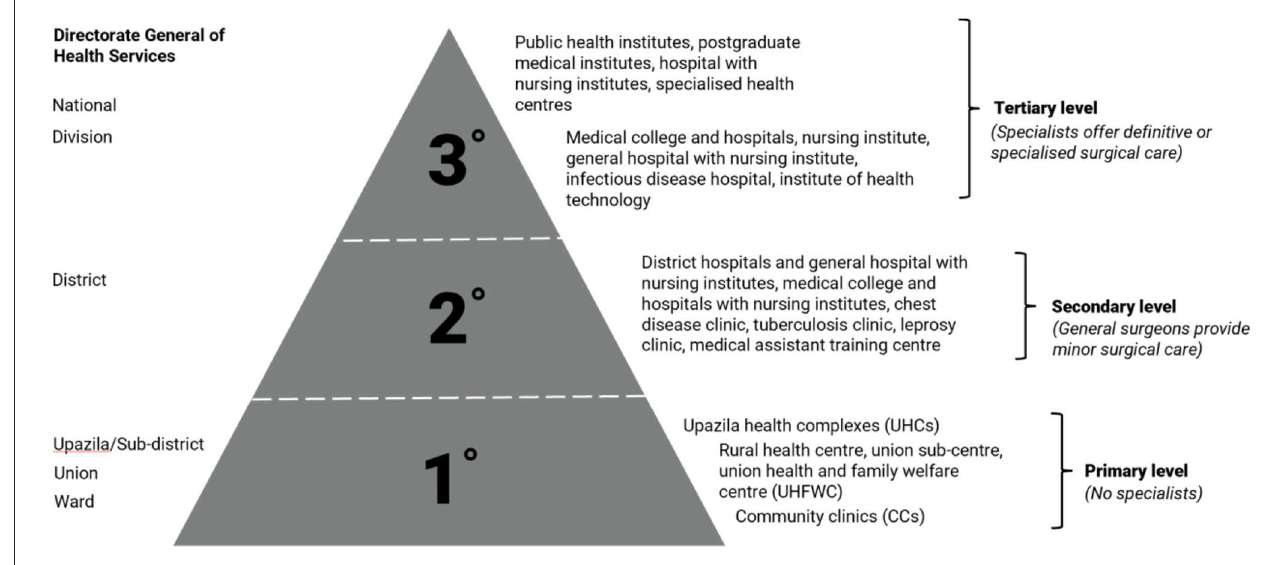
FIGURE1 Hierarchy of Bangladeshi healthcare facilities under the directorate general of health services (11).